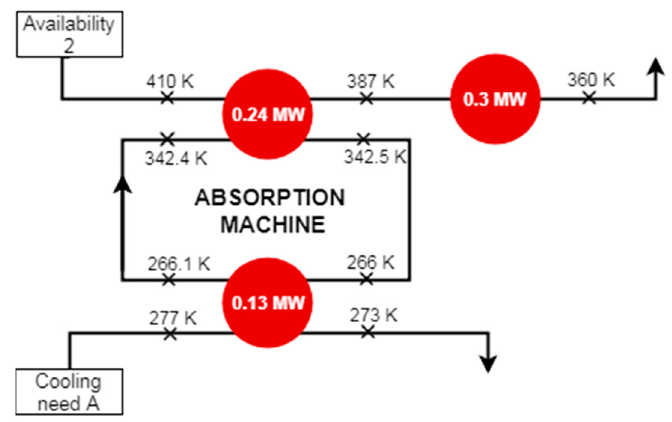
Figure 17. Absorption machine assessment.